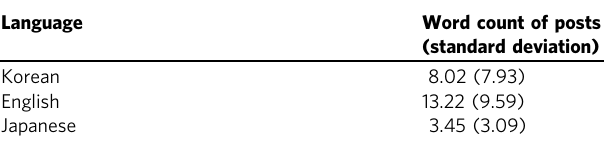
Table 2 Data description for each